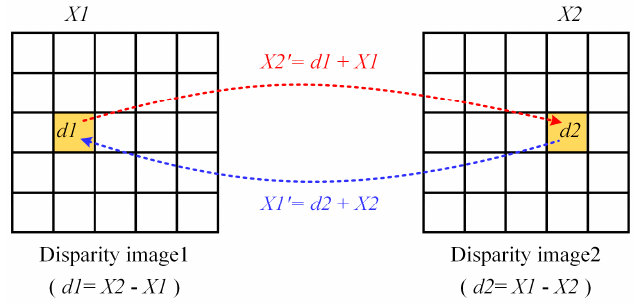
Figure 7. Location transformation between homonymous points in an epipolar stereo pair.